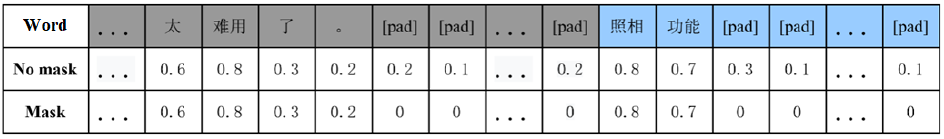
Figure 2. Masking mechanism of attention. The first row shows a word sequence with [pad] labels. The attention scores of the according words are shown in the second row, and the results after masking [pad] scores are in the third row.